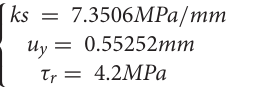
M-RJ2 sample can be computed by substituting the relevant test data in Equation 16 and Equation